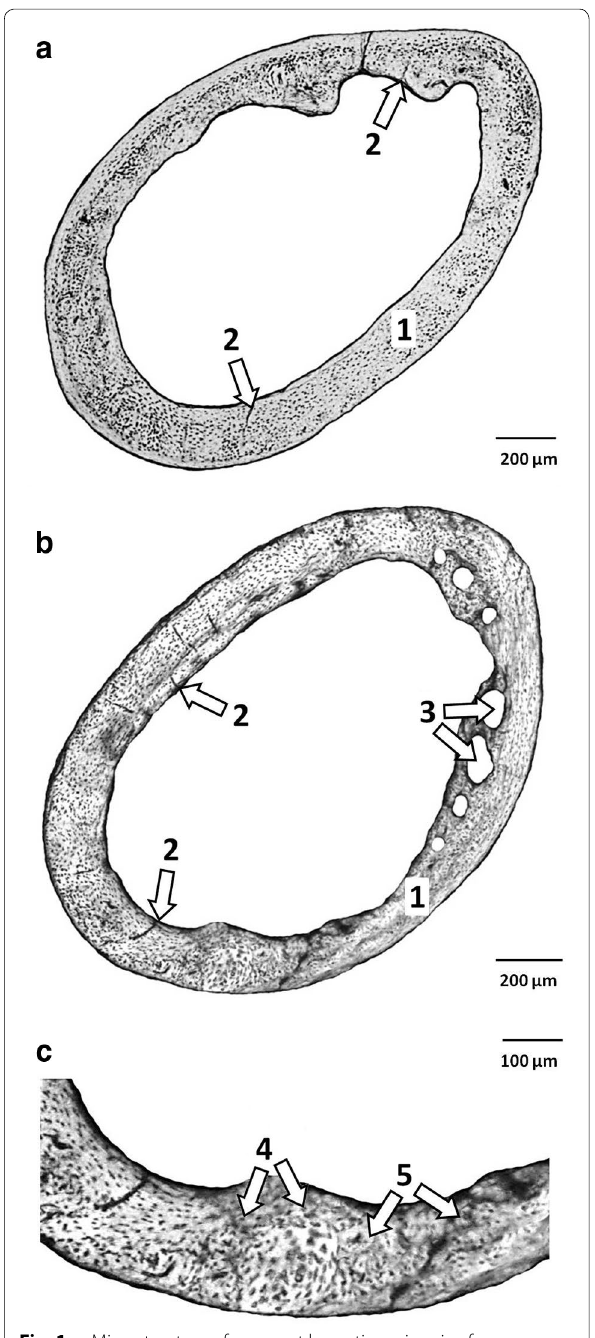
Fig. 1 a Microstructure of compact bone tissue in mice from group C. 1—Non-vascular bone tissue. 2—primary vascular radial bone tissue. b Microstructure of compact bone tissue in mice from group E. 1—Non-vascular bone tissue, 2—primary vascular radial bone